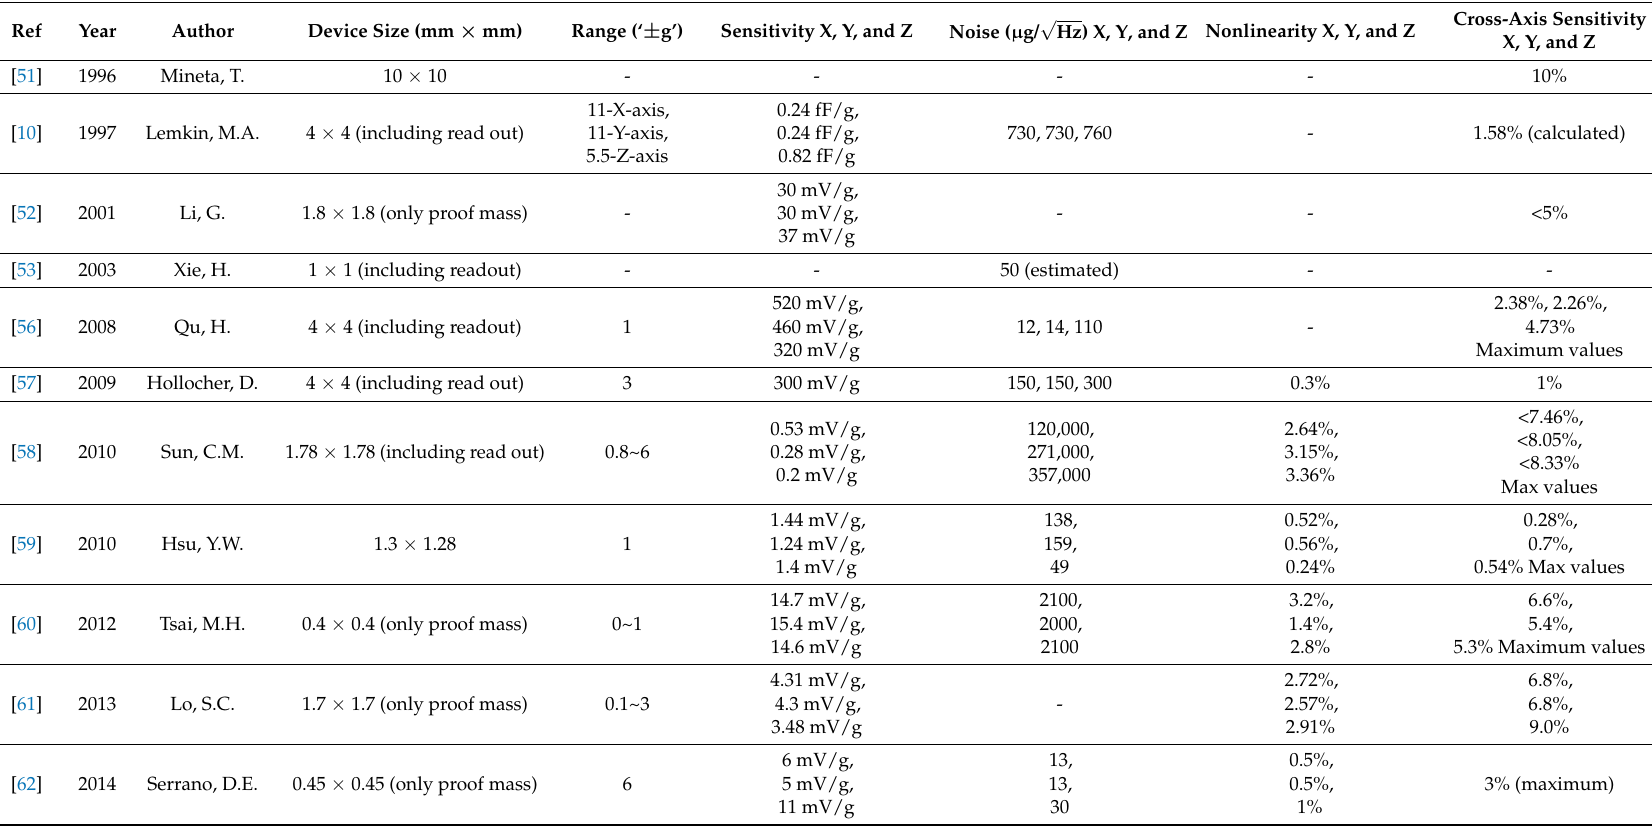
Table 2. Performance summary of three-axis single proof-mass